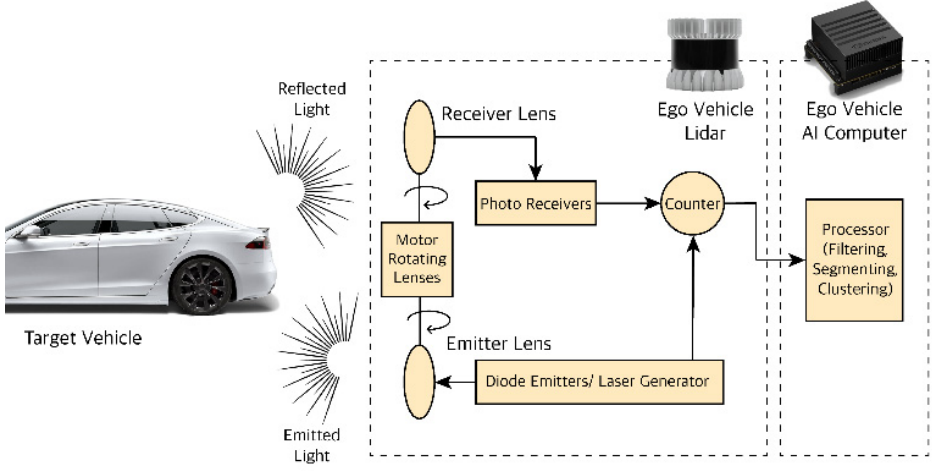
Figure 5. LiDAR Distance measurement [54].